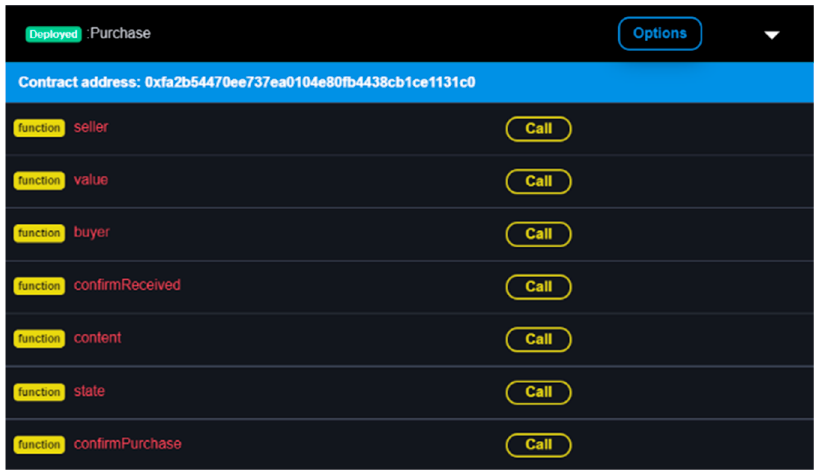
Figure 8. Trade smart contract deployment results.